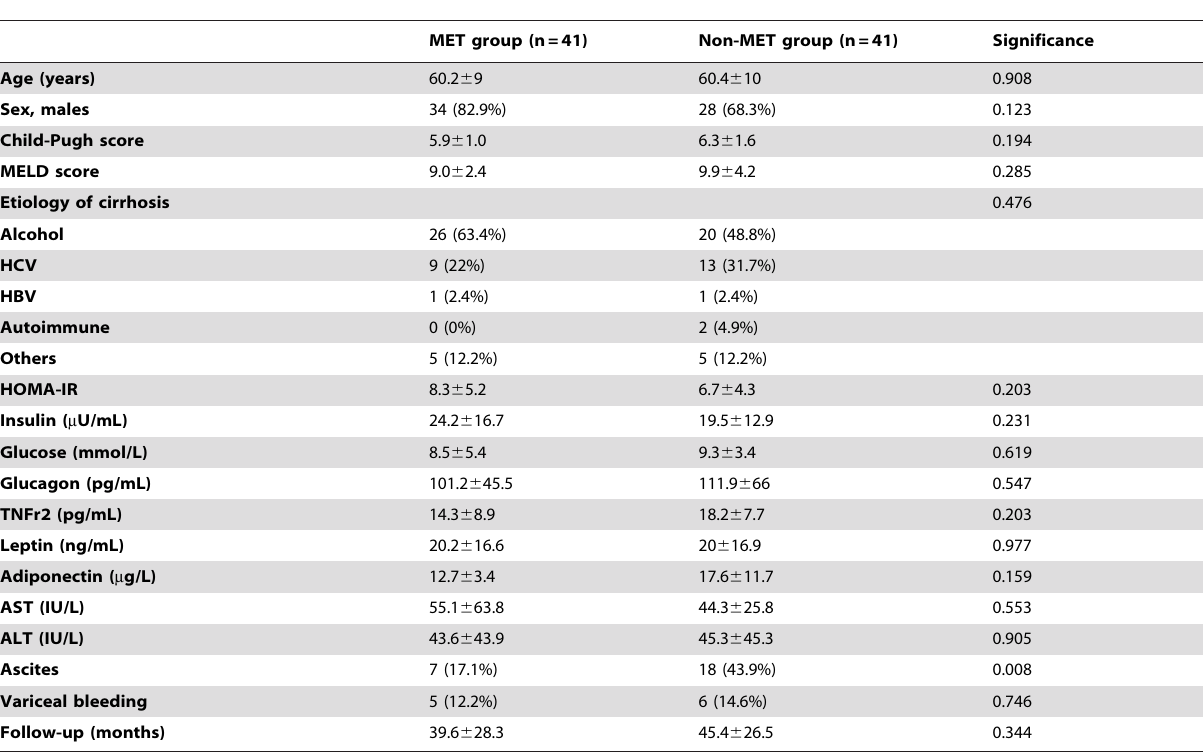
Table 1. Comparison of baseline characteristics between groups.